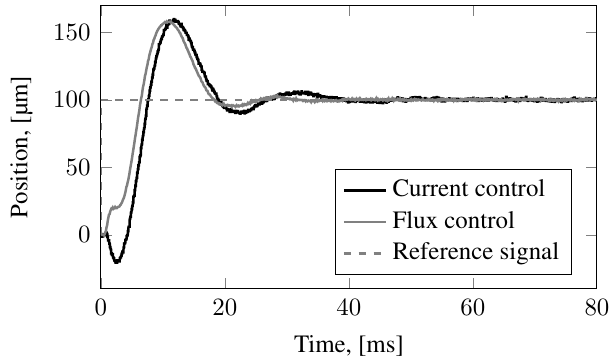
Figure 7. Measured maximum singular values for output sensitivity functions at a standstill.